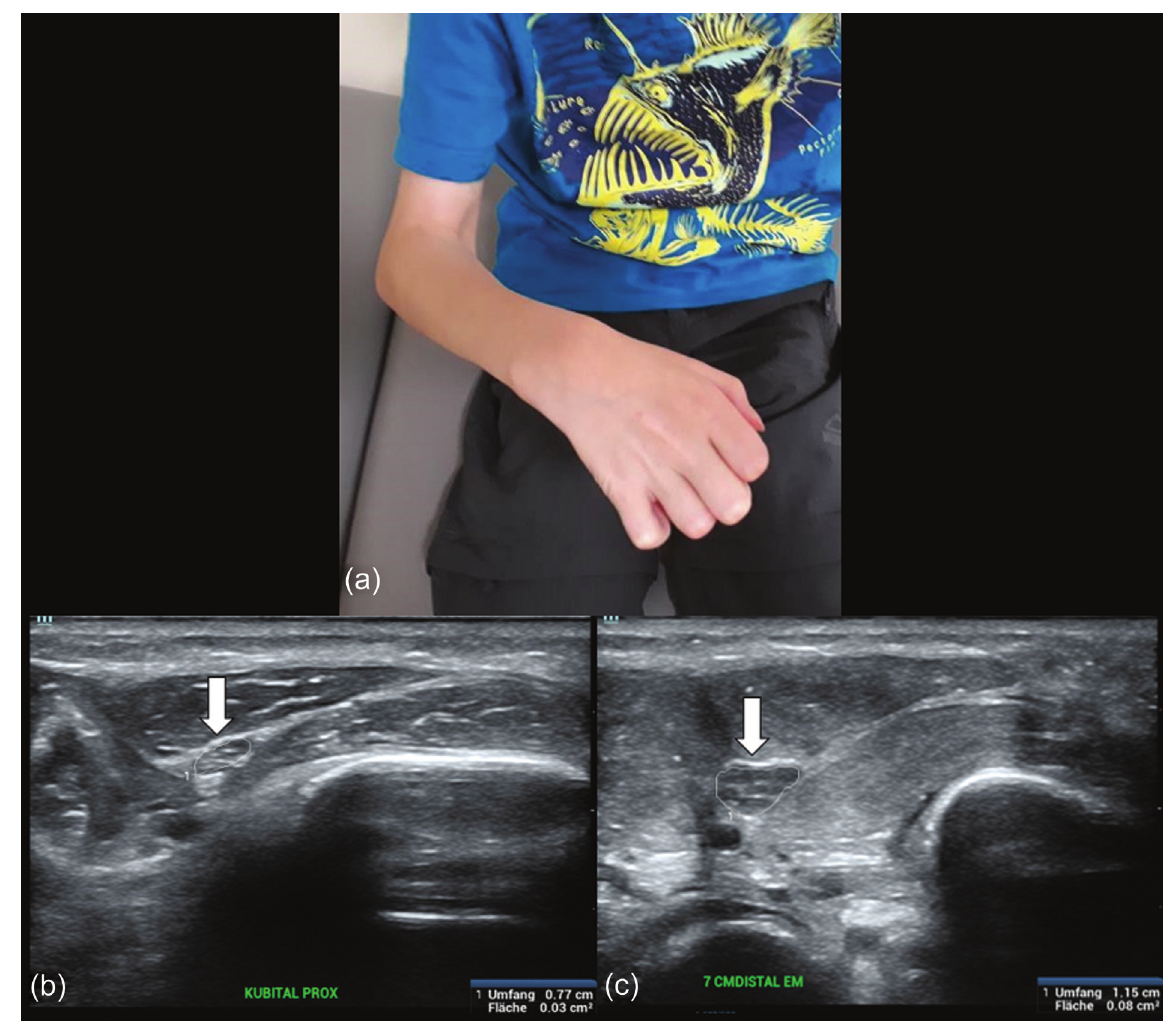
Fig.1 ( a ) Clinical picture of Volkmann ischemiccontracture preoperatively and ( b and c ) nerve ultrasonographyof the ulnar nerveat cubital and forearm